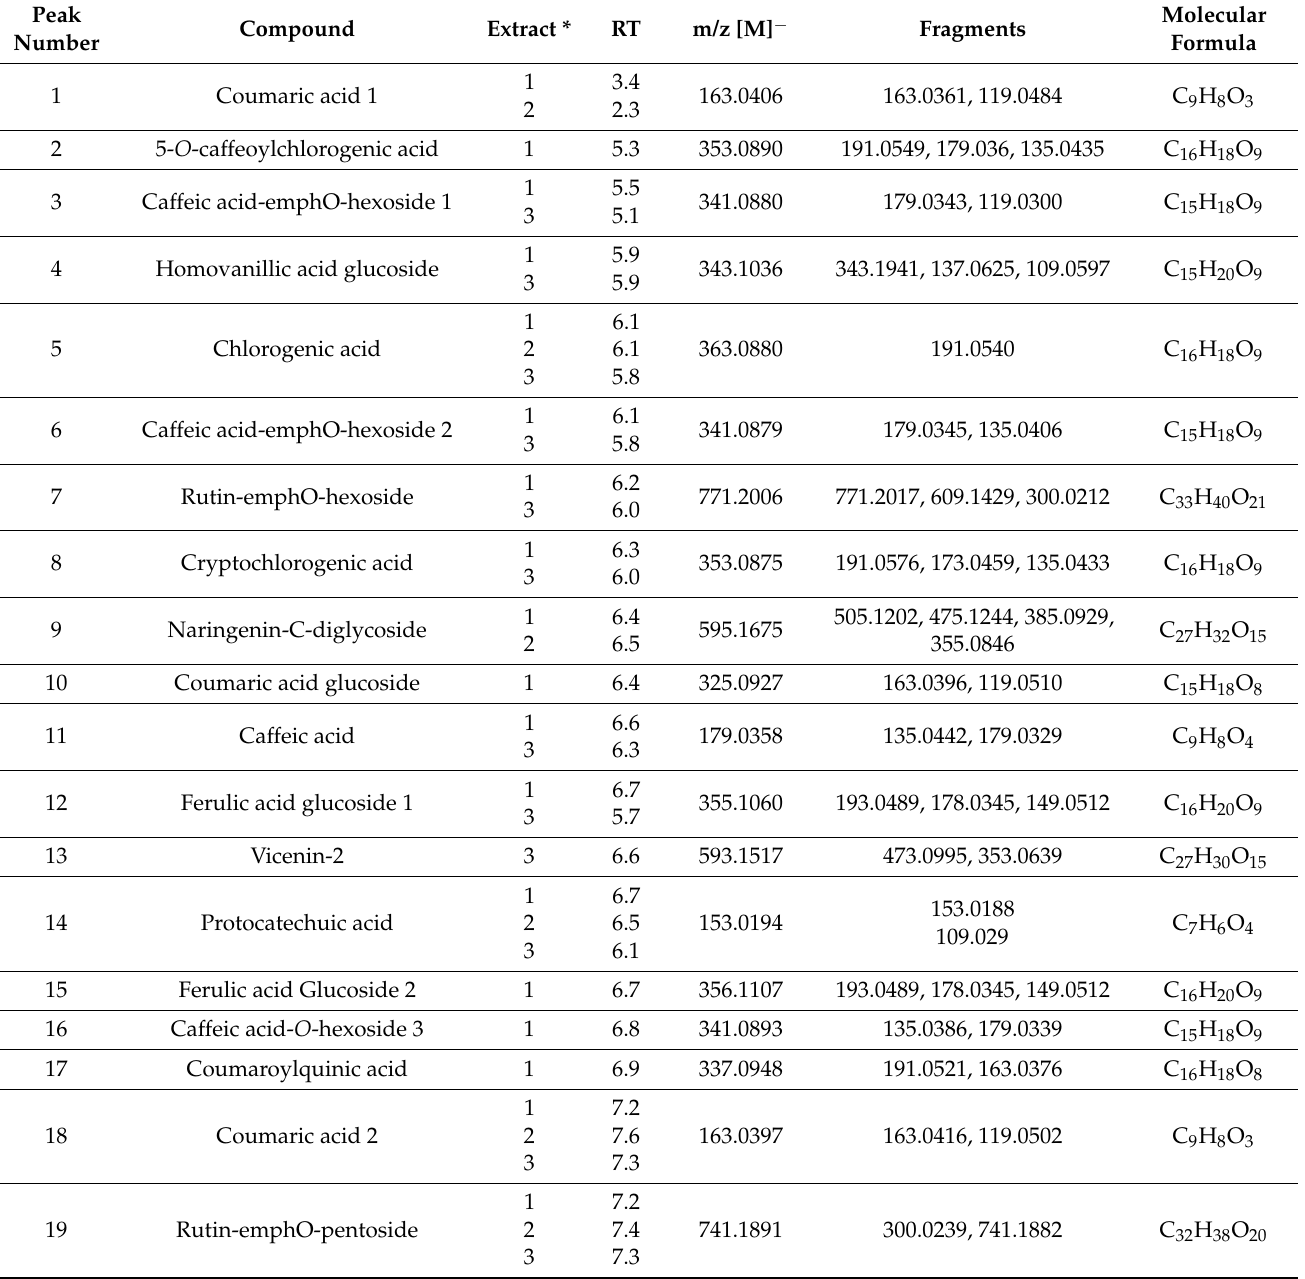
Table 1. Phenolic compounds present in tomato